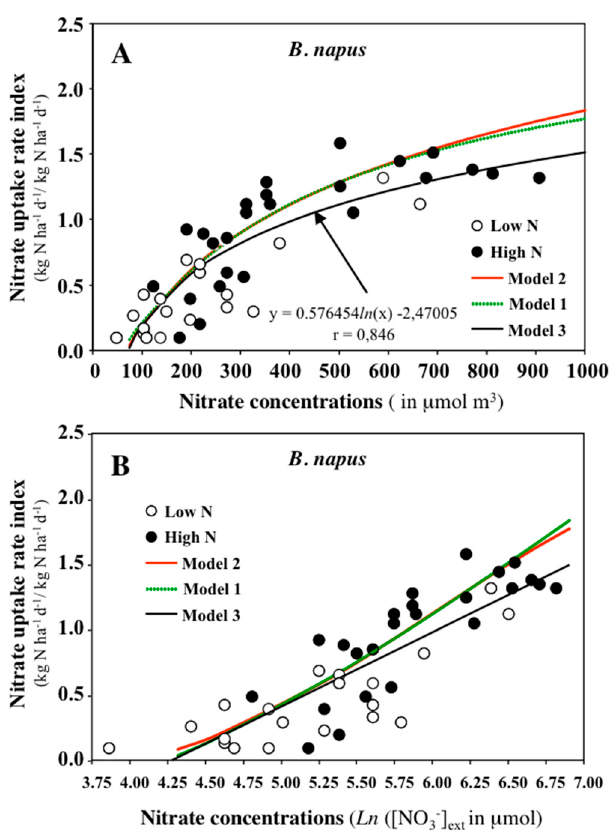
Figure 4. ( A ) Relationships observed between nitrate uptake rate index (NUI) and soil nitrate concentrations in 0–30 cm soil layer for oilseed rape ( B. napus ) in field experiments (adapted from [22]). The different models correspond to mathematical adjustments with a single hyperbolic function (model 1), a double hyperbolic function (model 2), and a logarithmic function (model 3). ( B ) Linear transformation in semi-logarithmic coordinates { N upt /dt ; [NO 3 − ] ext } of the relationships obtained in A. The linear curve in model 3 is based on the flow–force interpretation of ion transport in plants (adapted from [29]). In this interpretation, the slope of the linear curve in model 3 is a measurement of the overall conductance ( L j ) of the root system for nitrate and the intersection of plot on the abscissa (i.e., N upt /dt = 0) enables us to estimate a thermodynamic parameter π j (adapted from [11,29]; see § 3.2).